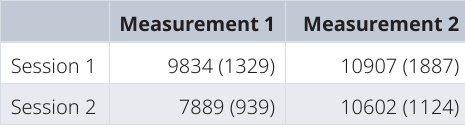
Table 2. Mean heart rate variability (HRV) and standard error of the mean (in parenthesis) for all the sessions and